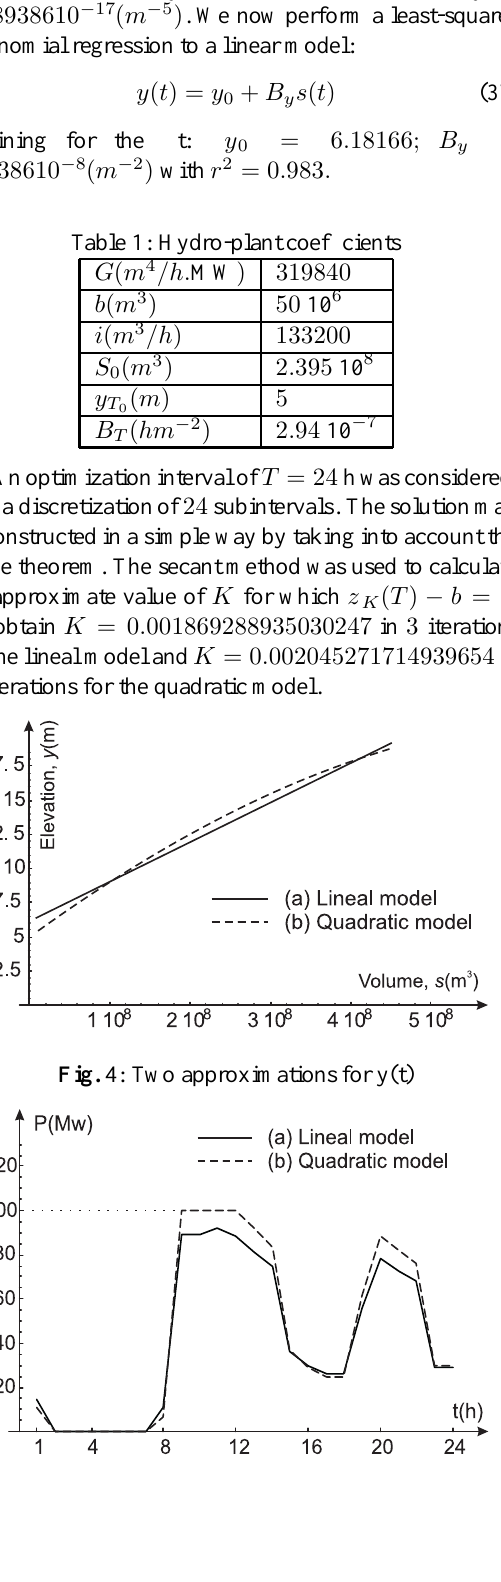
Fig. 5: Optimal hydro-power P(t) Table 2 presents the optimal solution (optimal rate q (10 6 m 3 /h ) and optimal hydro power P (MW), together with the clearing price π ( euro/h. MW ) for t = 1 , . . . , 24 ( h ) corresponding to the Spanish market. We use the su- perscript l to denote the solution obtained using the linear model and the superscript q the solution obtained with the quadratic model.